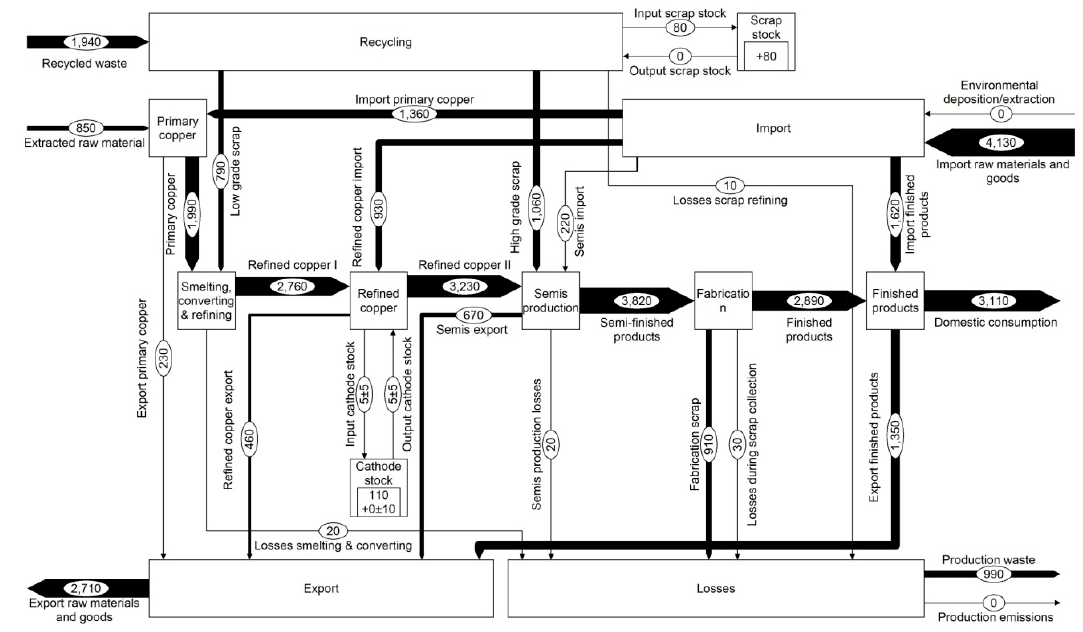
Figure A7. EU 28 Cu system 2014, subsystem production.